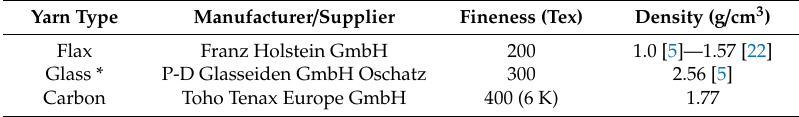
Table 2. Yarn types used for the manufacture of the hybrid